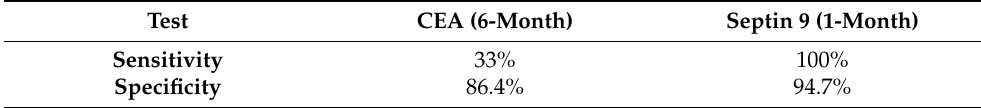
Table 4. Comparative analysis CEA values and SEPT9